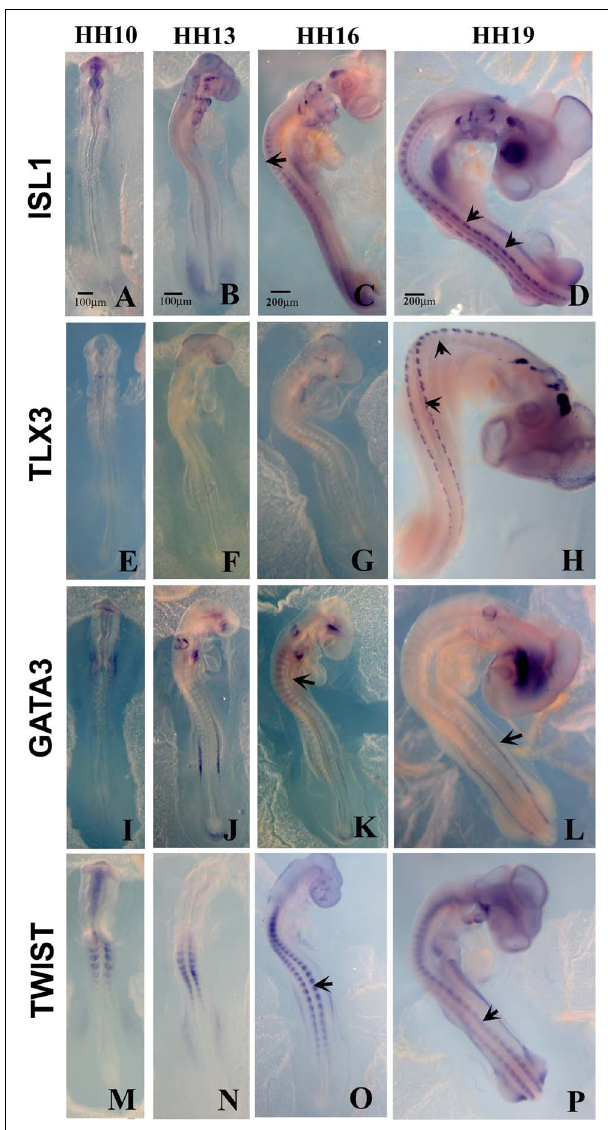
FIGURE 4 | Expression of upregulated genes. Chicken wholemount in situ for set of 4 upregulated genes at HH10, HH13, HH16, and HH19 chicken embryos. (A–D) ISLT1. (E–H) TLX3. (I–L) GATA3. (M–P) TWIST. Arrows point to migrating tNCC or coalescing DRGs. Scale Bars are for microns.